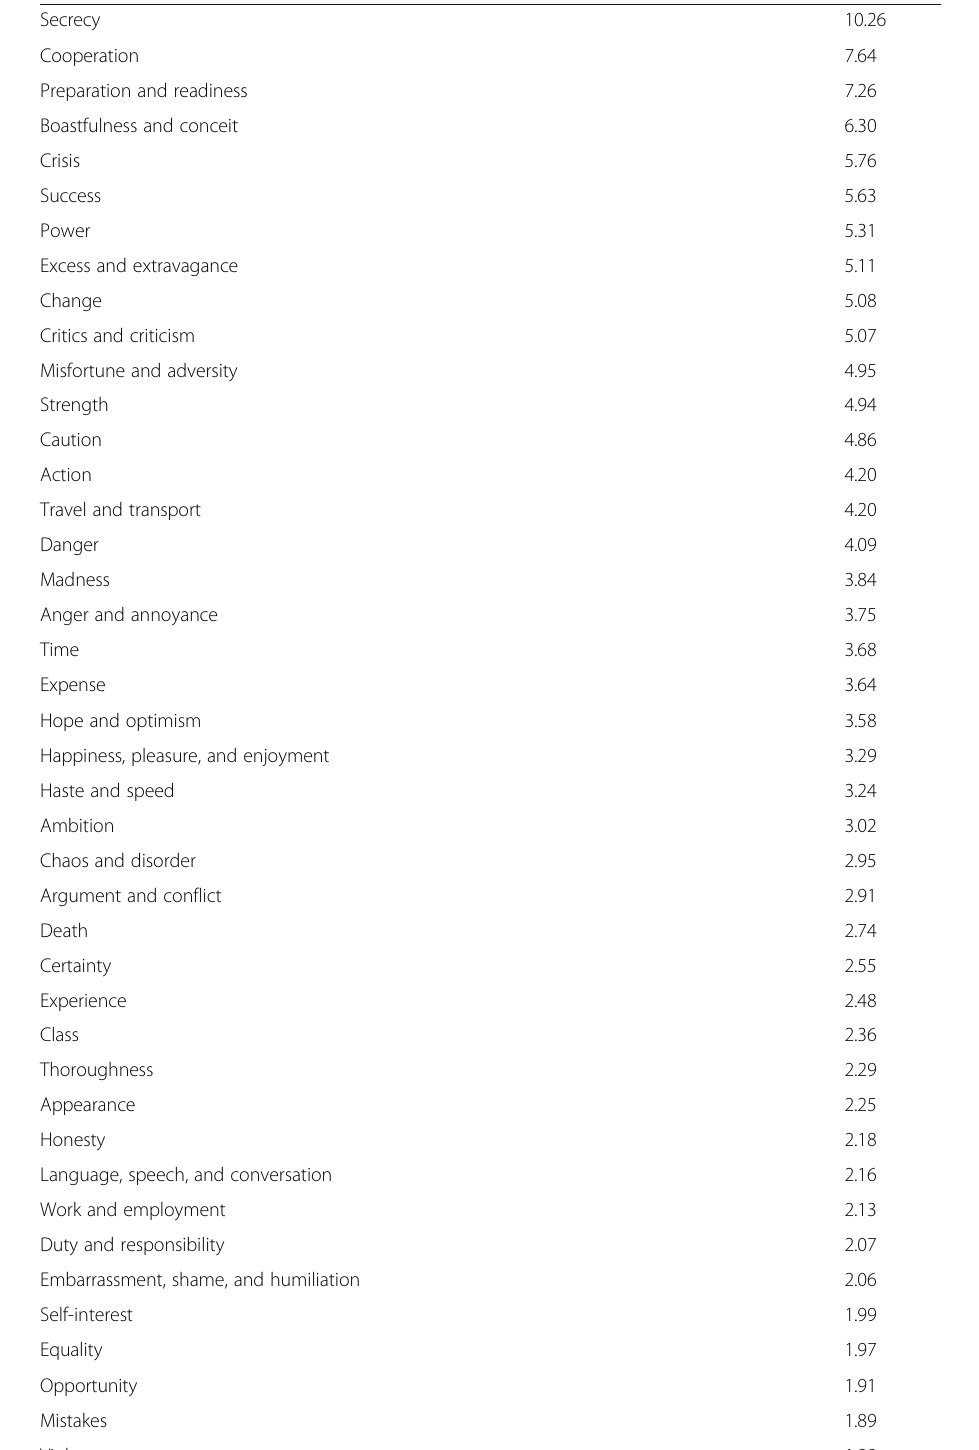
Table 4 The overall frequencies of the themes Theme Overall